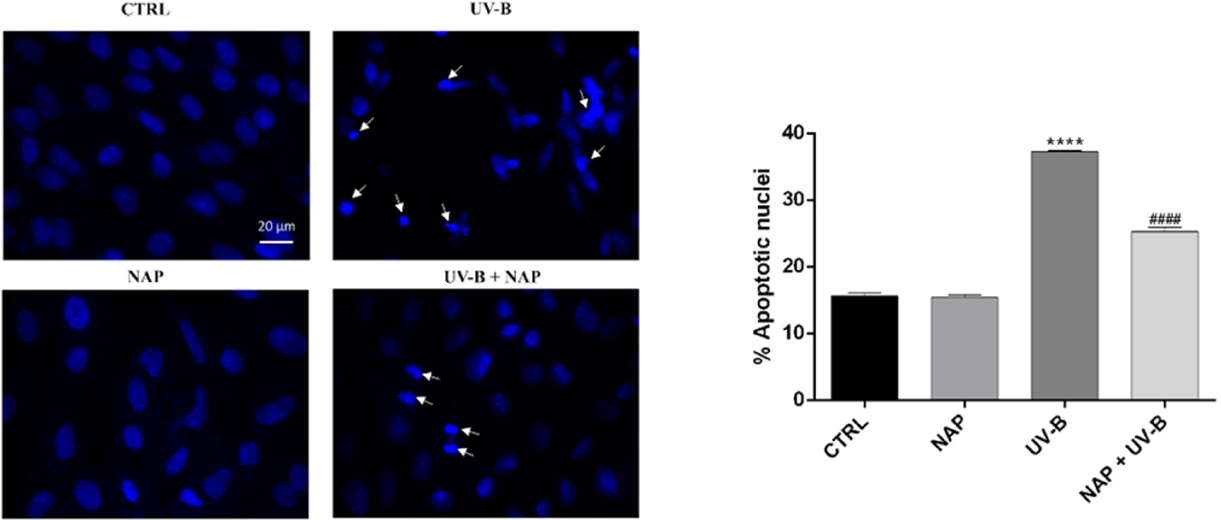
Figure 3. ( A ) Time–response curve following 30 s UV-B-irradiation of corneal epithelial cells. ( B ) Dose–response analysis of SIRC cells viability exposed to 30 s UV-B irradiation to various NAP concentrations for 24 h. The bar graphs represent mean ± SEM of three independent experiments and values are expressed as % of CTRL. **** p < 0.0001 vs. CTRL; #### p < 0.0001 vs. UV-B 24 h as determined by one-way ANOVA followed by Tukey’s multiple comparison test. Twelve replicate wells were used for each group.